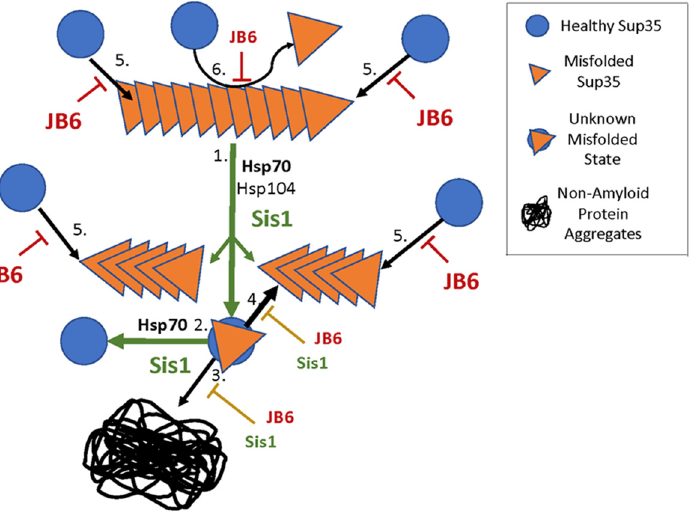
Figure 6. Possible ways that Sis1 and DnaJB6 (JB6) help keep Sup35 soluble in [ PSI + ] S cells. The blue circles represent properly folded Sup35. The orange triangles represent misfolded [ PSI + ] S Sup35. The stacked orange triangles represent Sup35 prion amyloid sheets that grows by adding Sup35 monomer to its ends and converting them to amyloid as they join the fiber (arrows 5). Green arrows show our proposed primary function of Sis1, which is to cooperate with Hsp70 and Hsp104 extract Sup35 monomers out of the amyloid sheet thereby dividing it into two smaller amyloids (arrow 1) that can continue to grow. The extracted protein represented by the overlapped circle and triangle is in an unknown misfolded state that has three different fates as shown by arrows 2–4. Sis1 with Hsp70 could refold Sup35 to its native conformation (arrow 2). The misfolded protein could aggregate in a non-amyloid manner (arrow 3), or the protein could re-join the amyloid, perhaps more readily than native Sup35 (thicker arrow 4). By promoting refolding (arrow 2), Sis1 would reduce arrows 3 and 4. Sup35 is capable of binding to the ends of prion amyloid at any point (arrows 5). Sup35 likely interacts with the surfaces of the amyloid, where secondary nucleation might also occur (arrow